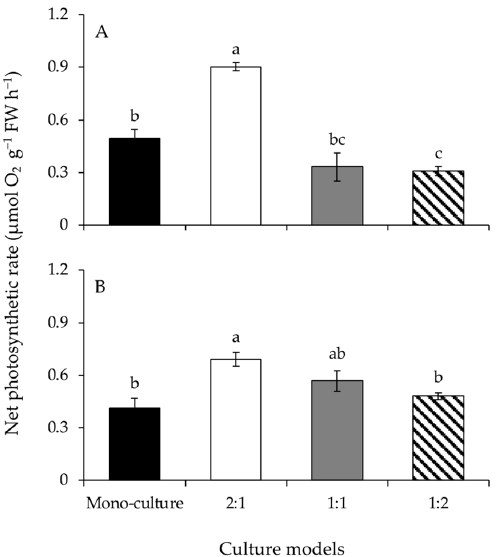
Figure 2. The net photosynthetic rates of Gracilariopsis lemaneiformis ( A ) and Sargassum horneri ( B ) cultured for twelve days at mono-culture and co-culture with biomass density ratios of 2:1, 1:1, and 1:2. Different lowercase letters represent significant differences ( p < 0.05) among culture